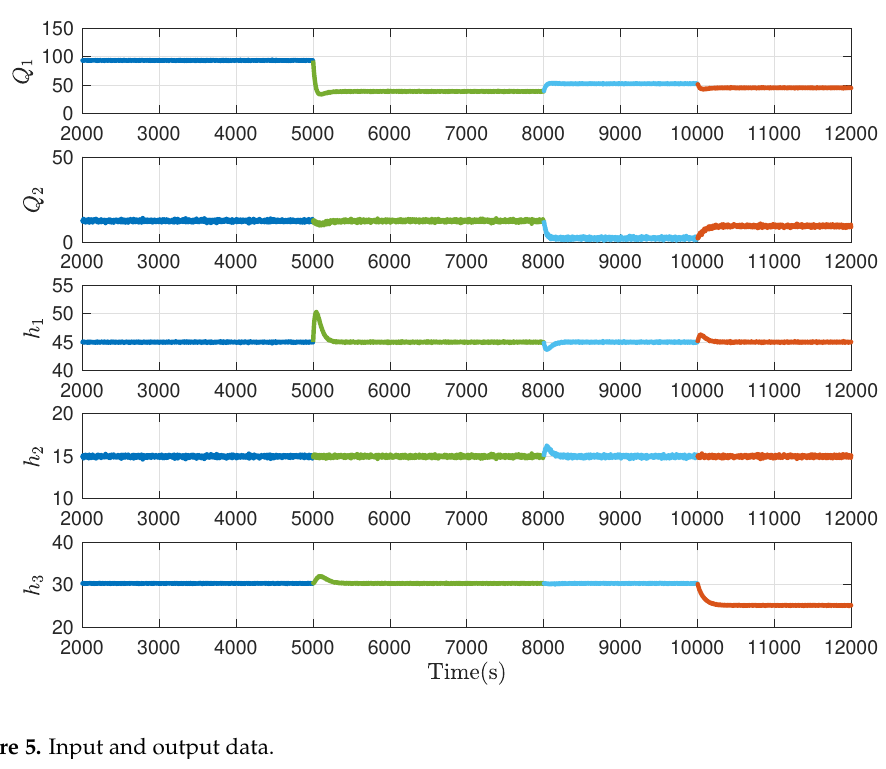
Figure 5. Input and output data.